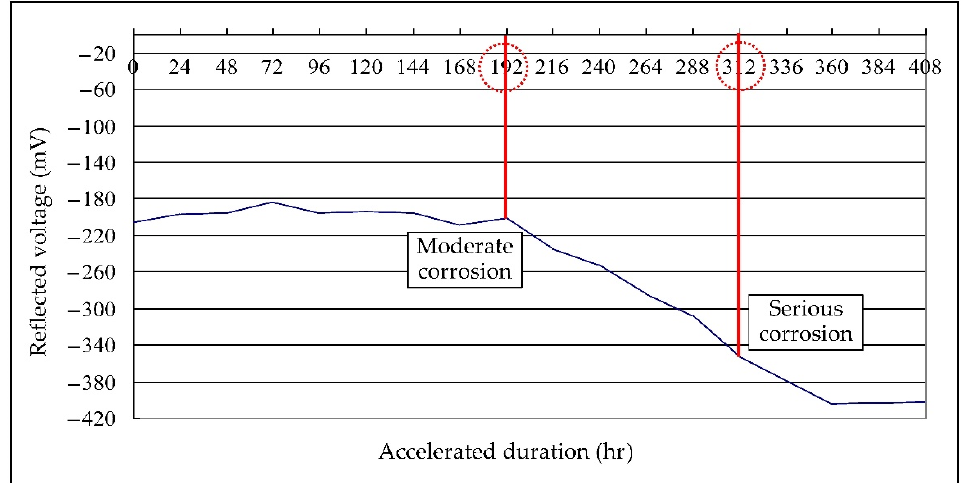
Figure 18. Corrosion Voltage for 6 cm Protective Layer.